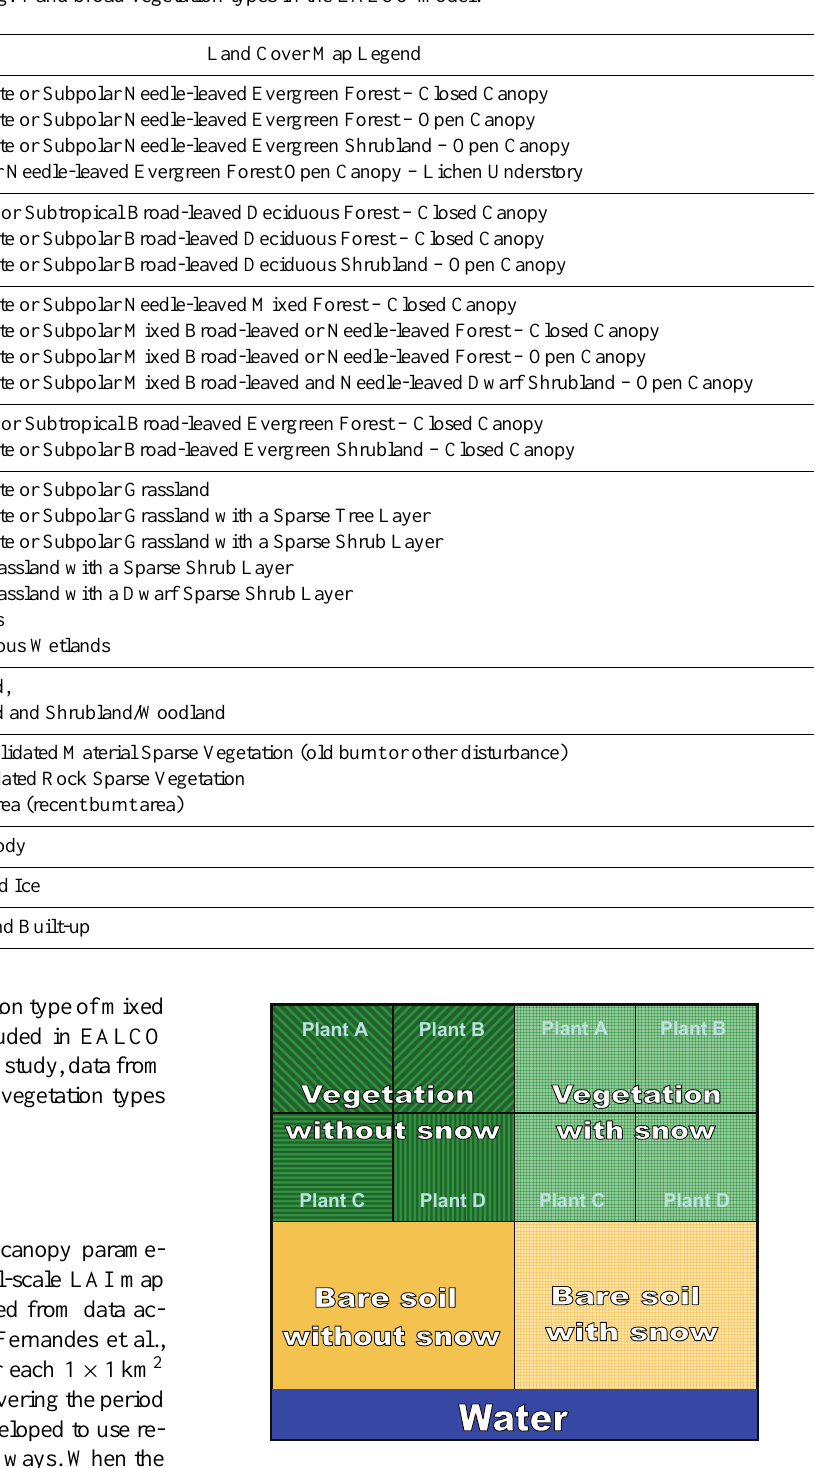
Fig. 2. The EALCO model scheme for a heterogeneous land surface